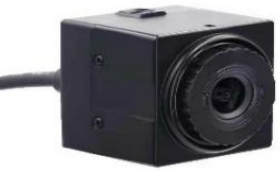
Figure 9. Display of some scenes from the TuSimple dataset.